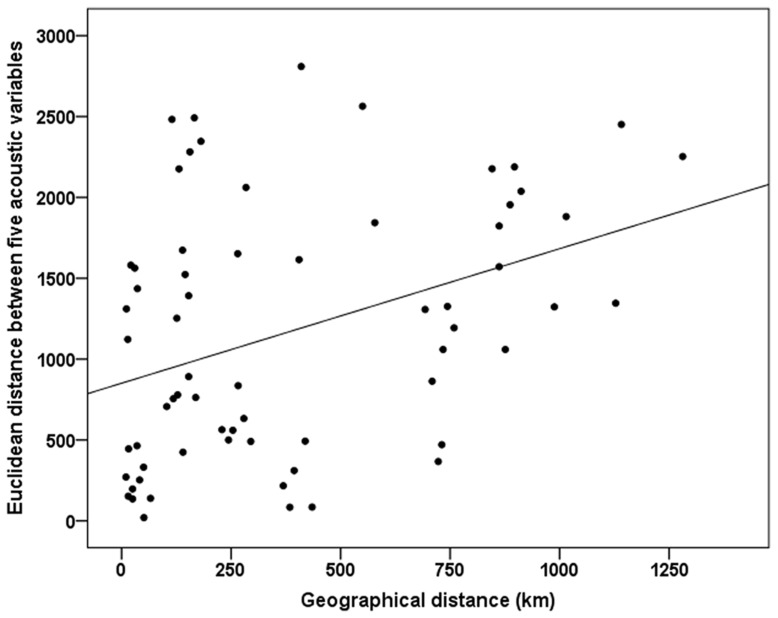
Results from a Mantel test analyzing the relationship between vocal variation (Euclidean distances based on the five acoustic variables between all the recording sites) and geographic distances between recording sites (R2 = 0.143; p = 0.036).